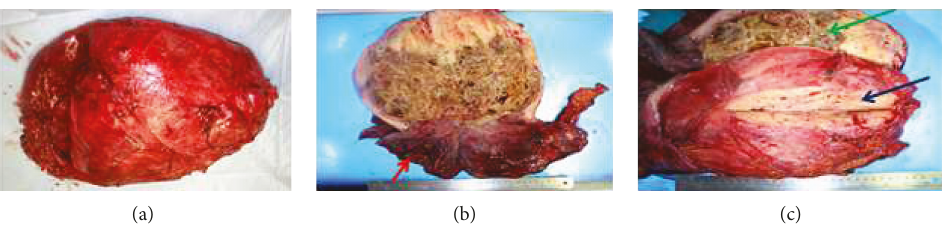
Figure 5: (a) Specimen: size was 30 × 25 × 10.5cm. (b) Specimen: right side of the tumor was a cystic component with wall thickening (red arrow). (c) Specimen: when tumor was incised, there was a mixture of solid components (blue arrow) and parts of honeycomb-like texture (green arrow).